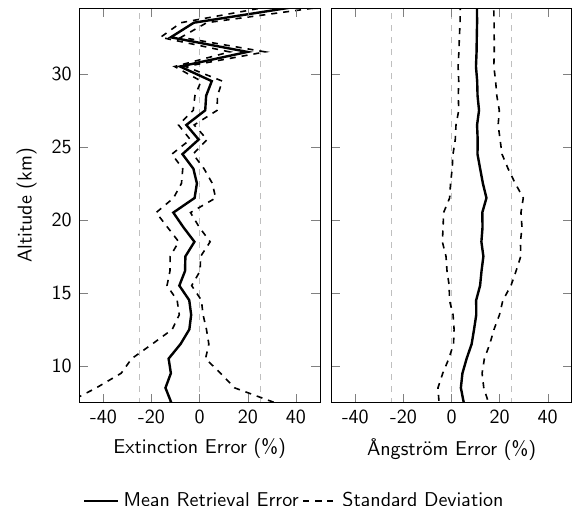
Fig. 7. Error in the retrieved parameters under a variety of simulated measurement conditions when the true atmospheric state is bimodal. Error using the coupled extinction and mode radius retrieval are shown in black with dashed lines showing the standard deviation.